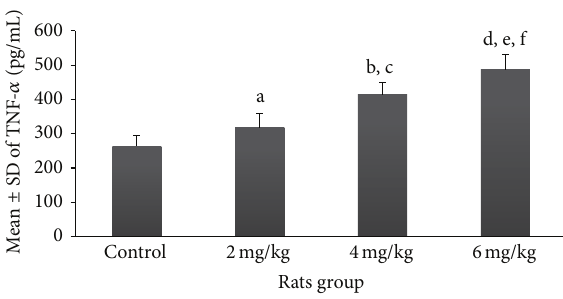
Figure 3: Prenatal exposure to nicotine in pregnant rats increased the inflammatory marker TNF- 𝛼 in newborn rats. Figure shows mean ± SD of the TNF- 𝛼 marker in different groups of newborn rats. 𝑁 = 8 (a: 𝑃 > 0.05 in 2 mg/kg group versus control group; b and c: 𝑃 < 0.001 and 𝑃 > 0.05 in 4 mg/kg group versus control group and 2mg/kg group, resp.; d, e, and f: 𝑃 < 0.0001 , 𝑃 < 0.0001 , and 𝑃 < 0.05 in 6 mg/kg group compared to control, 2mg/kg, and 4 mg/kg groups, resp.).